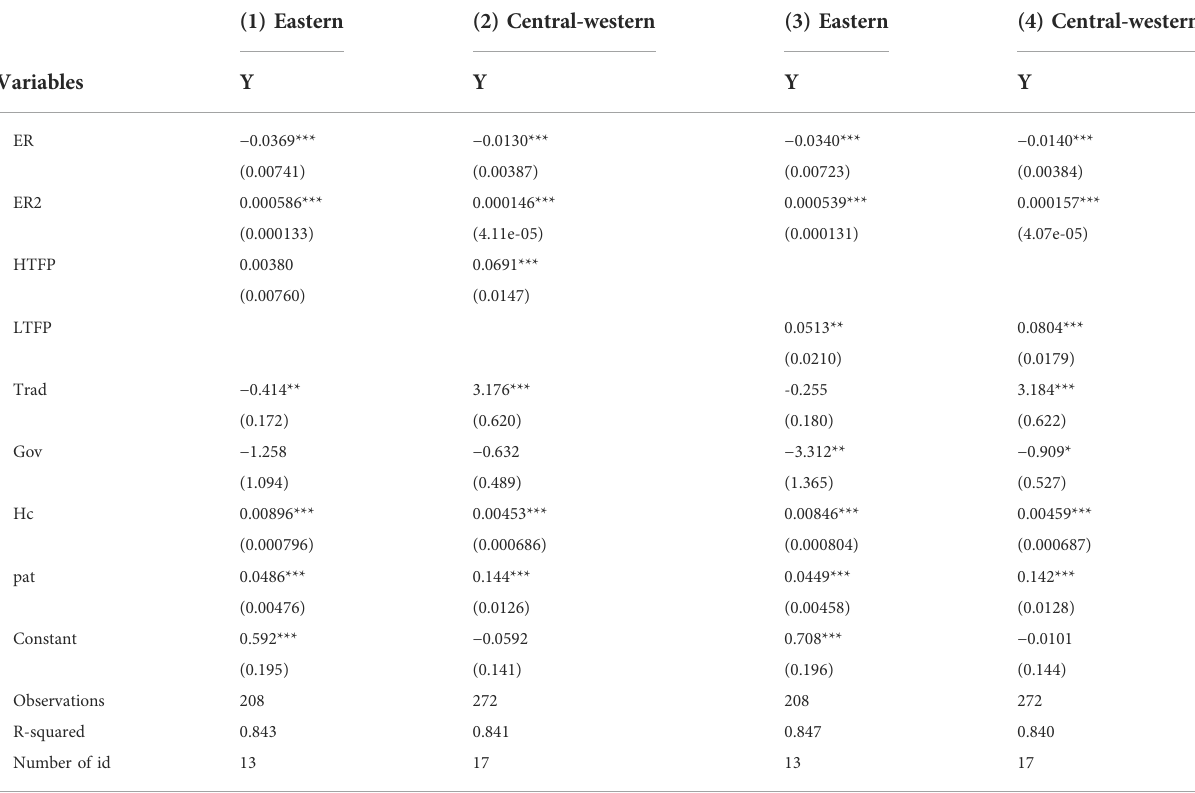
TABLE 8 Regression Results of Regional Model